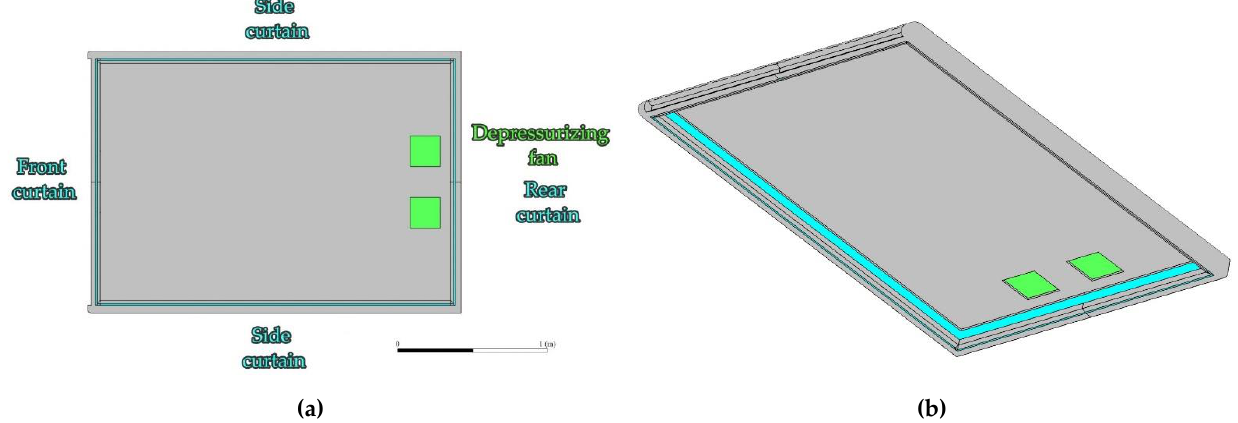
Figure 12. Geometry of the shell object of FDDG used for 3D CFD simulation of the moving object: ( a ) bottom view; ( b ) angled view from bottom.